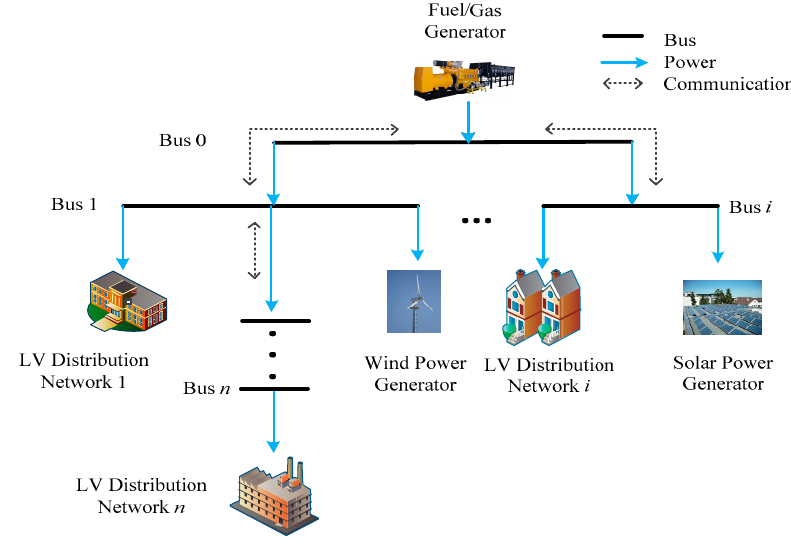
Figure 1. The microgrid framework.